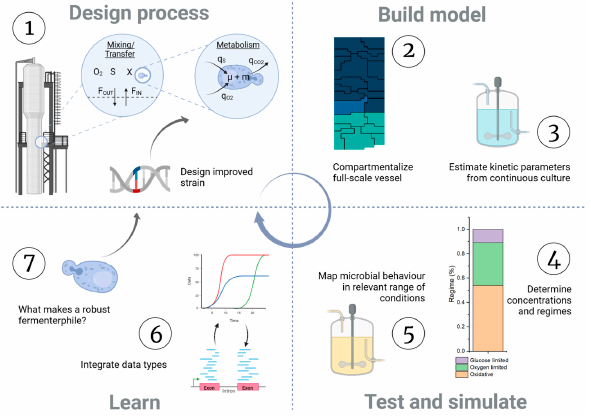
Figure 1. Graphical summary of the design–build–test–learn type of workflow used in this manu- script.